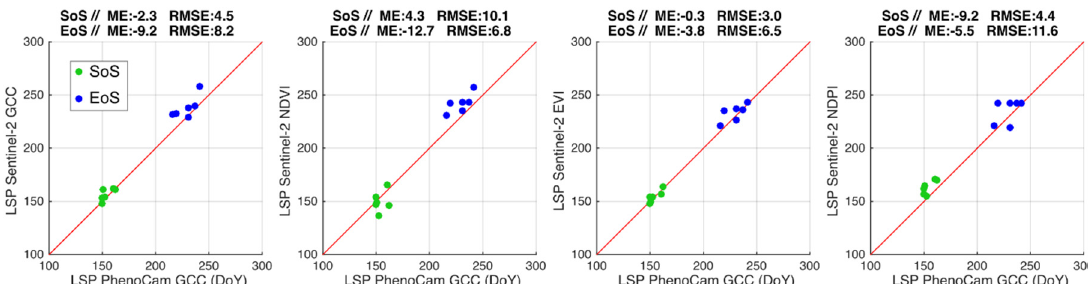
Figure 3. Comparison of start of season (SoS) and end of season (EoS) dates between PhenoCam and four vegetation indices estimated with Sentinel-2. The comparison was performed for three PhenoCam sites in the tundra biome for the years 2019 and 2020. The vegetation indices were the green chromatic coordinate (GCC) in PhenoCam and the GCC, normalized difference vegetation index (NDVI), enhanced vegetation index (EVI), and normalized difference phenology index (NDPI) for Sentinel-2. The phenology metrics were extracted with a 50% threshold method without time series smoothing. The bias between PhenoCam and Sentinel-2 is reported with the mean error (ME) and the accuracy with the root mean squared error (RMSE).